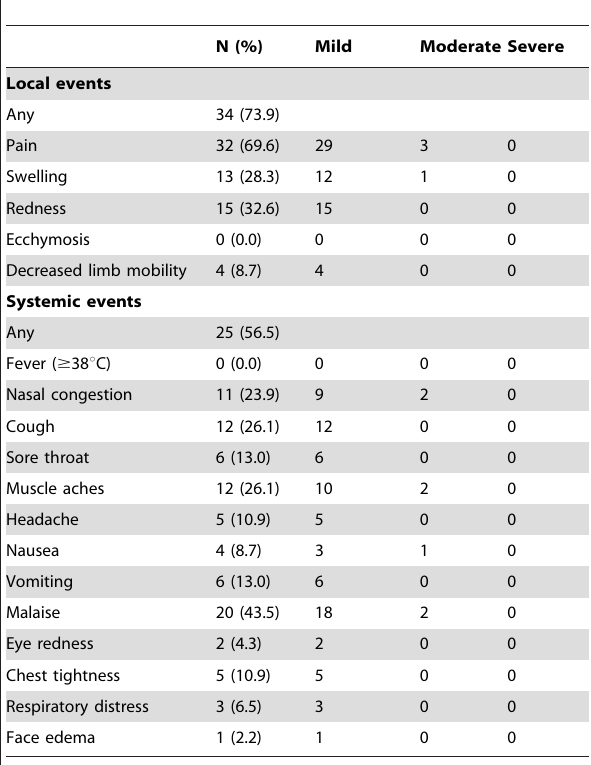
Table 5. Adverse events occurring within 7 days after vaccination in 46